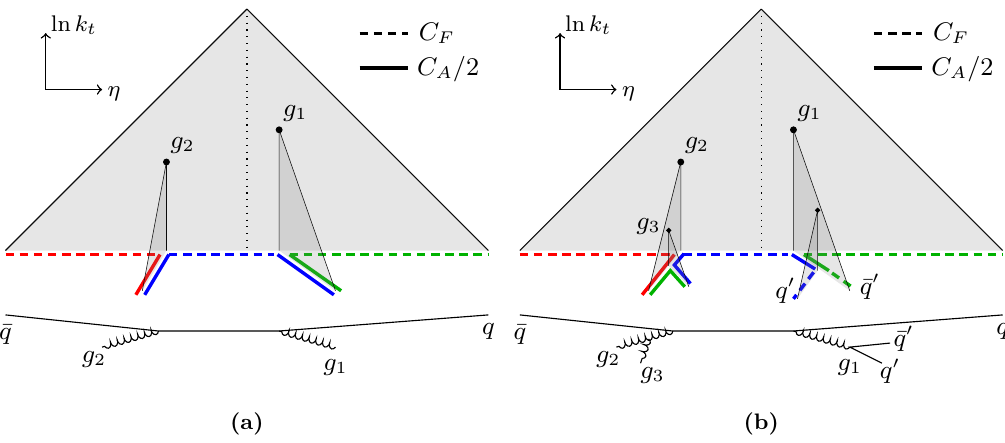
Figure 1. Two example events and associated Lund diagrams. Points in the Lund diagram represent branchings, the triangles represent the two-dimensional logarithmic phase-space, while the coloured lines at the base of the diagram represent the phase-space for individual colour-dipoles (at the corresponding k value), with dashed and solid segments indicating the parts of the dipole t that should be associated respectively with a C versus a C 2 colour F A /